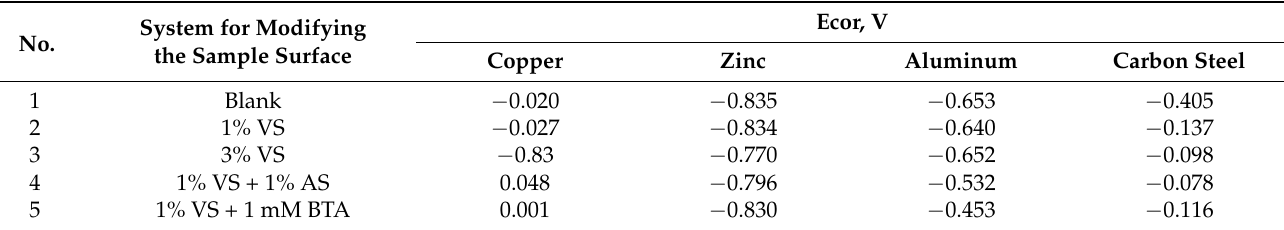
Table 2. Values of the corrosion potential (E cor ) of metal samples without pretreatment of the surface and modified with organosilane-based compositions. Borate buffer (pH 6.7) was used with the addition of 0.1 M